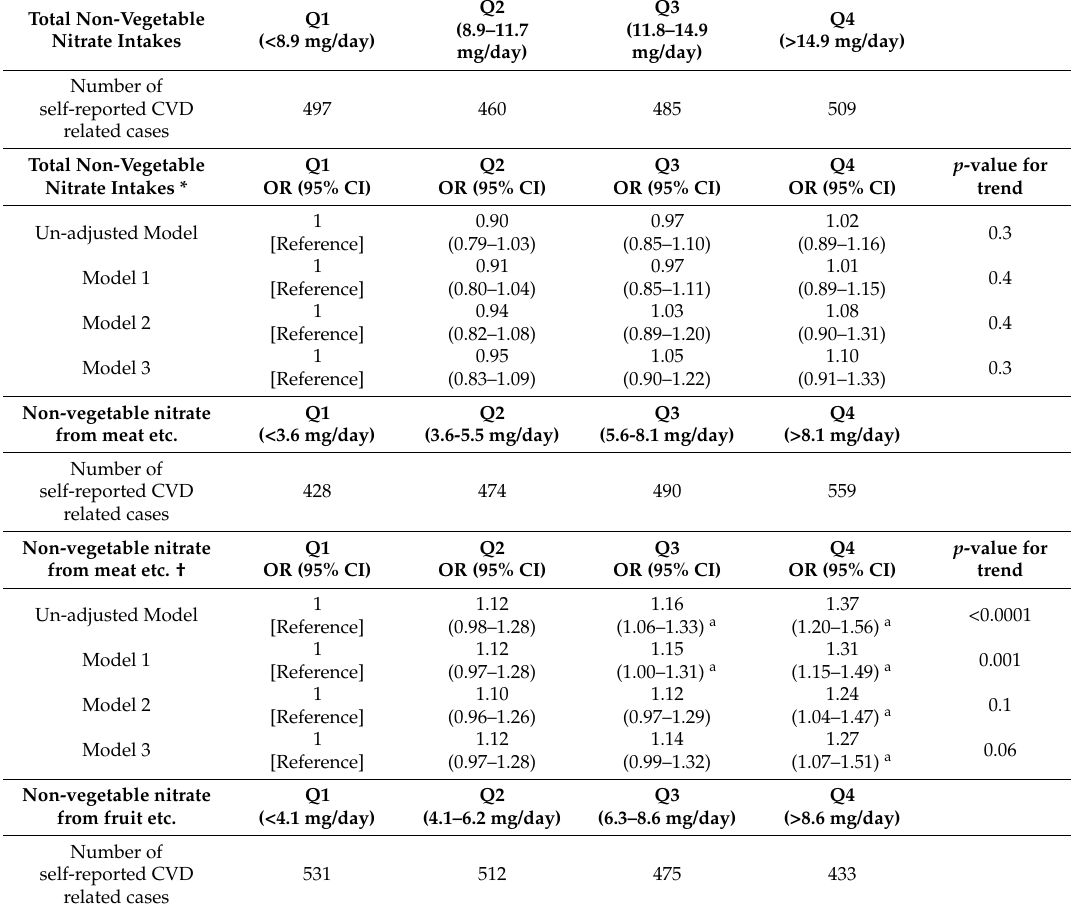
Table A1. Odds of self-reported CVD related complications by quartile of non-vegetable nitrate intakes in the 1946–1951 cohort of the ALSWH